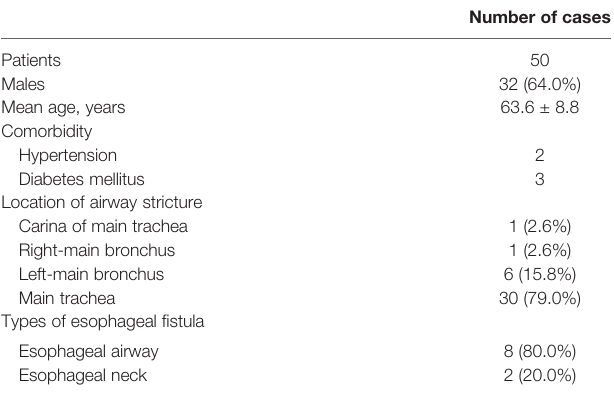
TABLE 1 | Patient characteristics.